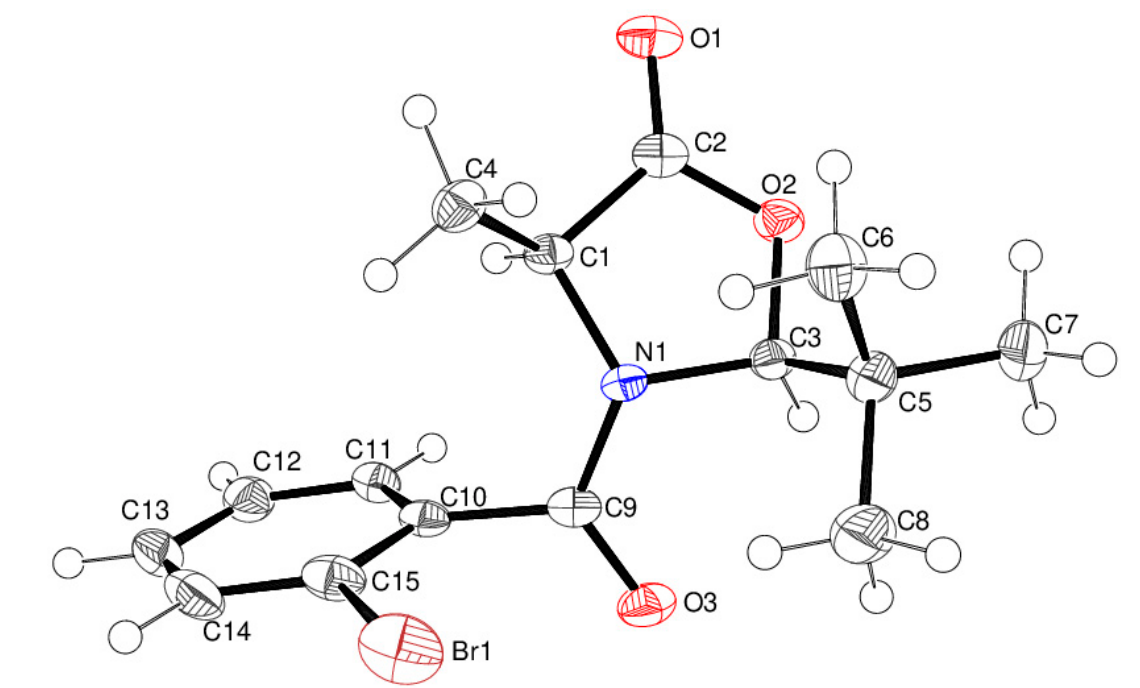
Figure 2. The asymmetric unit of ( II ) showing 50% displacement ellipsoids. Figure 2. the asymmetric unit of ( II ) showing 50% displacement ellipsoids.